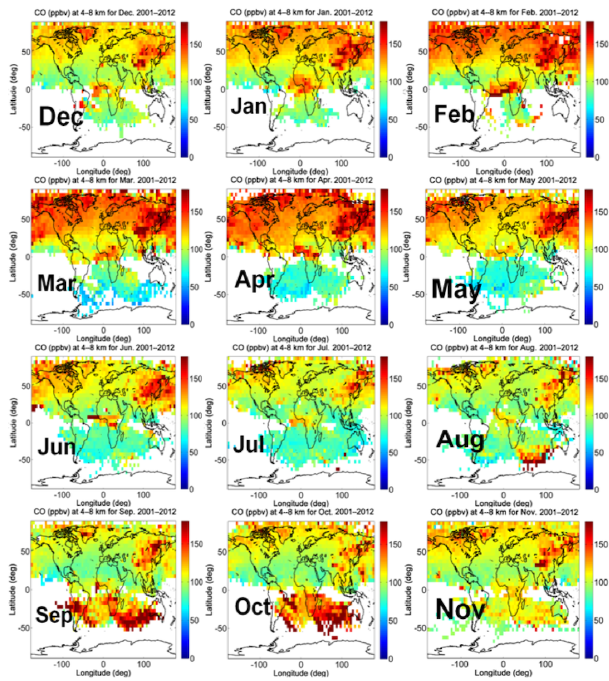
Figure 14. Global monthly mean CO distribution from the trajectory-mapped MOZAIC-IAGOS CO VMR as a function of lat- itude and longitude for January–December 2001–2012 and altitudes between 4 and 8kma.s.l. The data are averaged with a bin size of 5 ◦ × 5 ◦